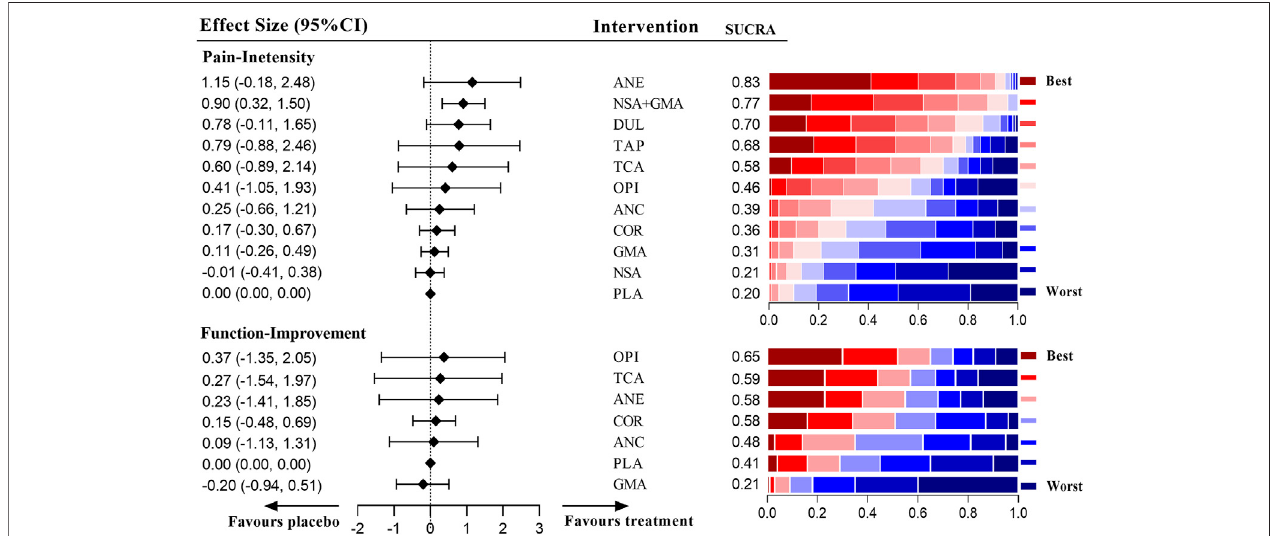
FIGURE 4 | Estimate effects and hierarchy of pharmacotherapies for radicular low back pain (LBP).